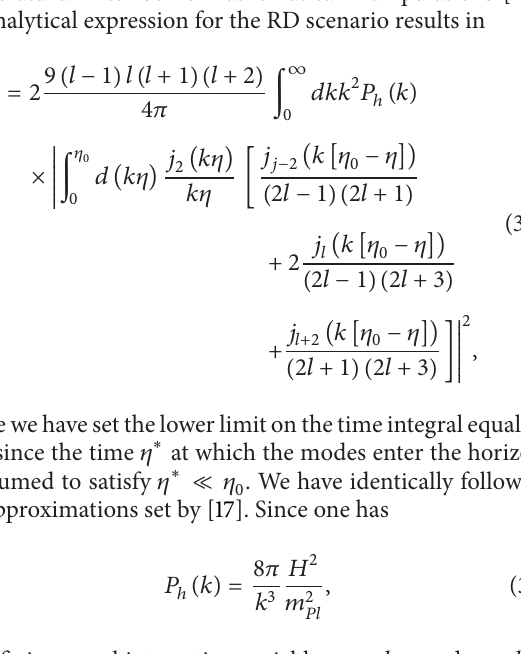
Figure 5: Tensor contribution to the angular power spectrum in the RMD scenario. Results are for vanishing anisotropic stress (dotted lines), for 𝑅 ] = 0.4 (0.4052) (dashed lines), and for 𝑅 ] = 1 (solid lines) for the collisionless case. The blue line corresponds to the analytical results obtained for a vanishing anisotropic stress component, where we have used an analytical transfer function to account for RD and MD